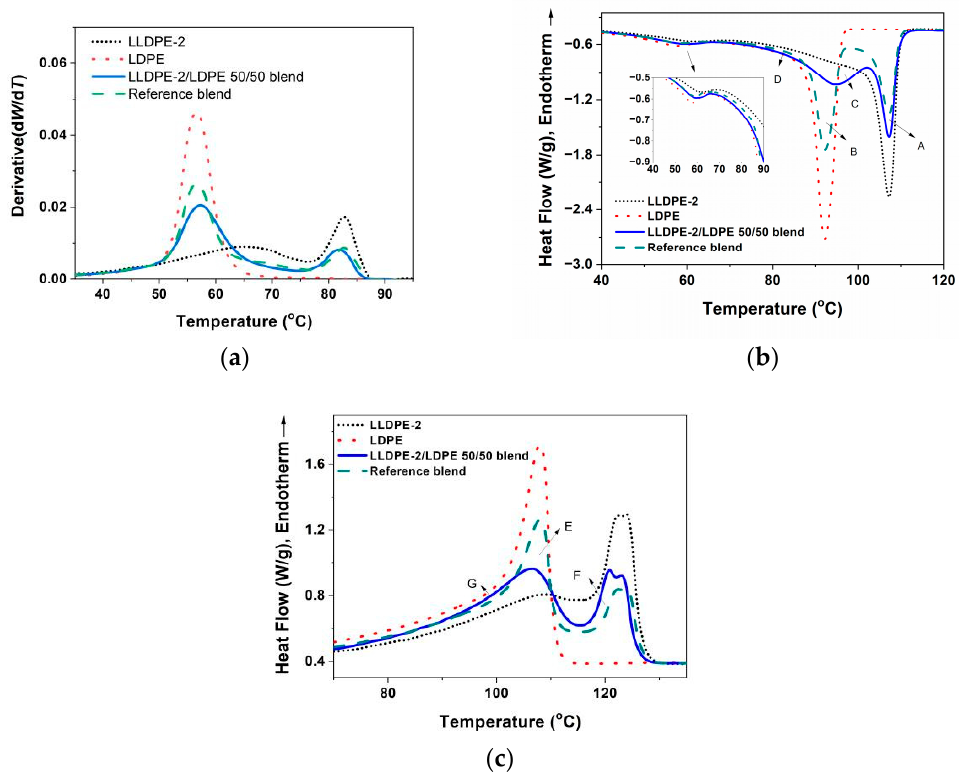
Figure 8. CRYSTAF pro fi les of LLDPE-2, LDPE, and LLDPE-2/LDPE 50/50 blend ( a ), DSC cooling curves ( b ) and subsequent heating curves ( c ) of the LLDPE-2/LDPE 50/50 blend compared with calculated reference blend curves. “A” – “G” in the fi gures indicates the area between the LLDPE-2/LDPE 50/50 blend curve (solid line) and the reference blend curve (dashed line) at the corresponding locations.